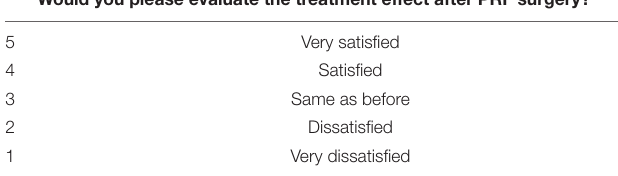
TABLE 1 | Five-point Likert